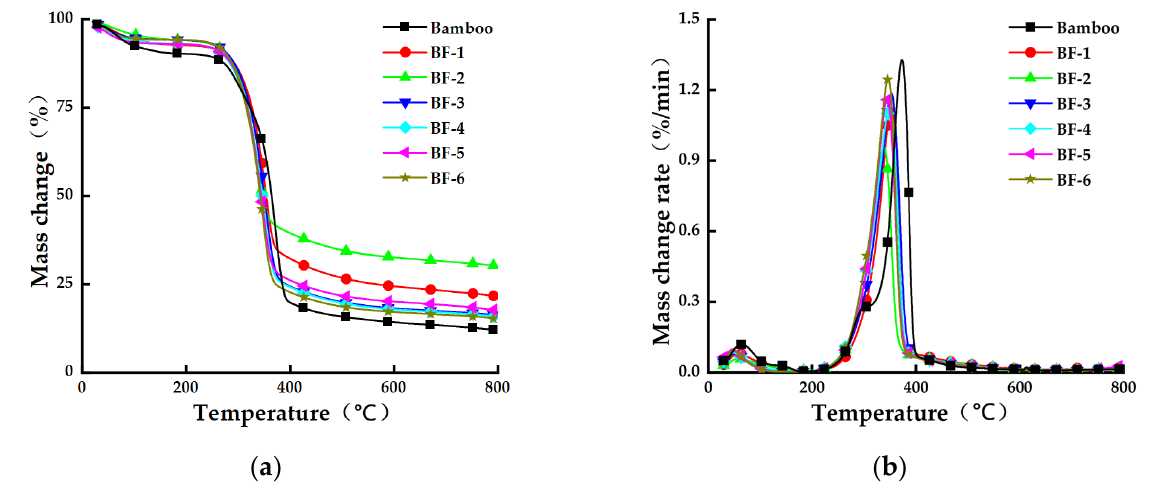
Figure 5. Pyrolysis curves of bamboo fibers with different opening times. ( a ) Mass change–temperature correspondence curve. ( b ) Mass change rate–temperature correspondence curve.